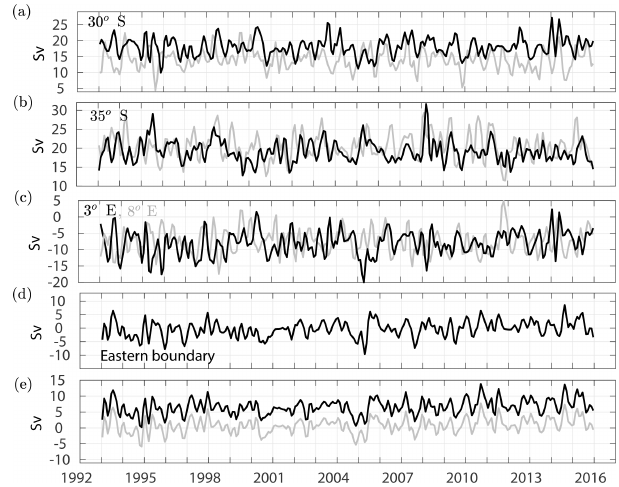
Figure 5. Time series of transports in the upper 800m. (a) Merid- ional transport of the Benguela Current at 30 ◦ S (black – across line AB; gray – across line A (cid:48) B; see Fig. 2). (b) Meridional transport of the Benguela Current at 35 ◦ S (across line CD in black; across line C (cid:48) D in gray). (c) Zonal transport at 3 ◦ E (across line AC; across A (cid:48) C (cid:48) ). (d) Cross-shelf transport at the eastern boundary near the African coast across 1000m isobath (across line BD). (e) Transport imbalance for ABCD (black) and A (cid:48) BC (cid:48) D (gray).